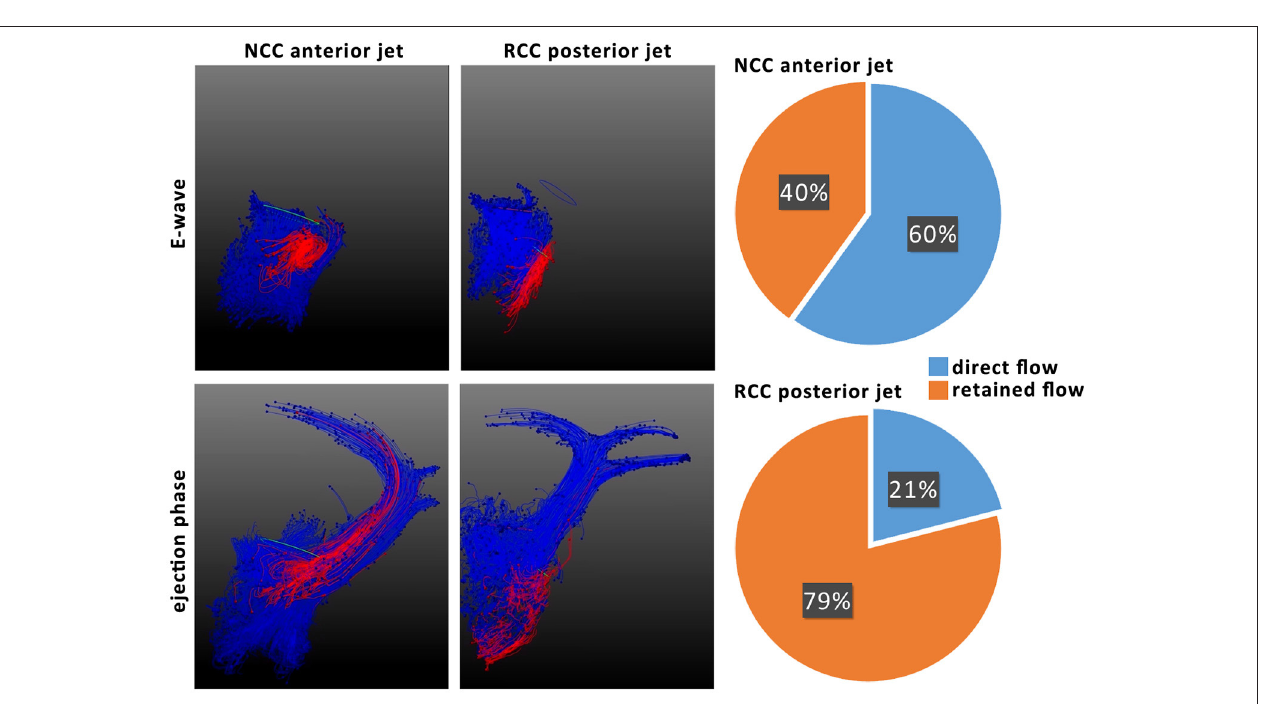
FIGURE 5 | Particle tracking of NCC and RCC regurgitant jets to illustrate residence time of regurgitant blood (left). Particles originating from mitral valve inflow are colored in blue and particles from the regurgitant jet red. Ratios of direct and retained flow of the regurgitant blood volume are shown on the right. Direct flow is the part of diastolic inflowing blood volume that is ejected in the next systole, whereas retained flow represents the diastolic inflow volume that resides in the ventricle for more than 1 heart